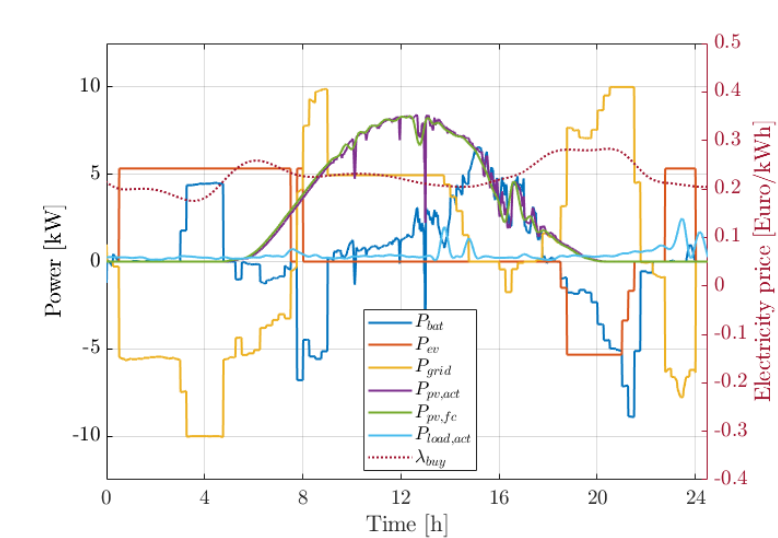
Figure 15. Curtailment of PV power due to reduced maximum allowable grid feed-in between 08:00 and 18:00.